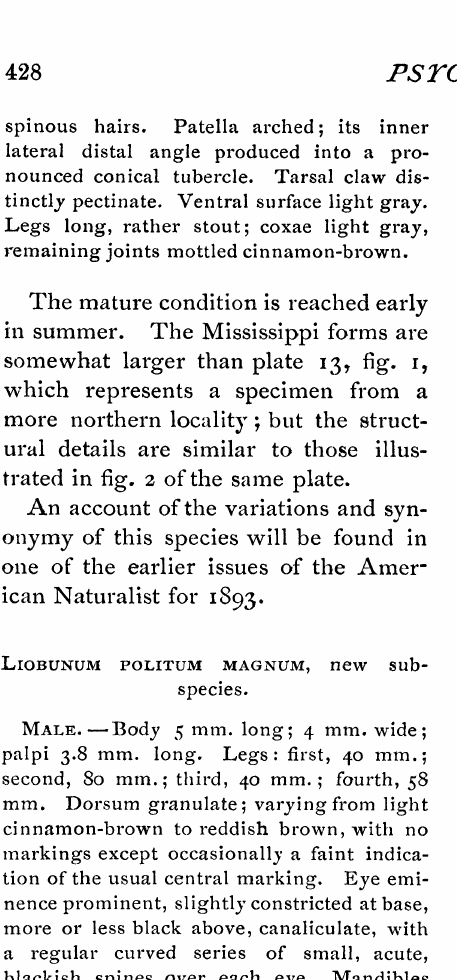
Fig. I.--Liobuntmvltlatum. Male. Natural size. 2.--Parts of same.